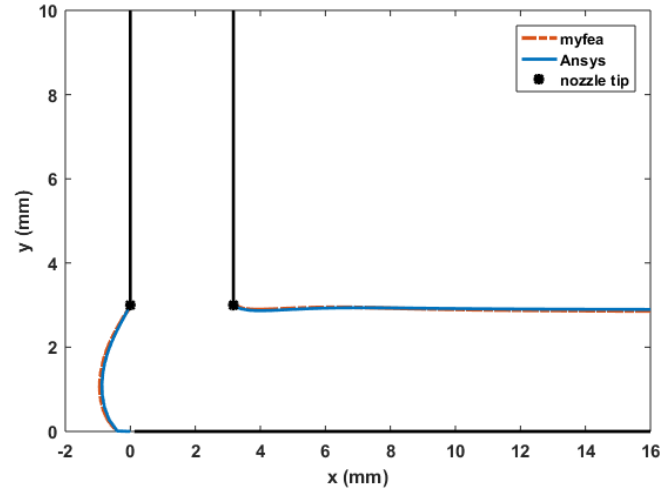
Figure A3. Velocity profiles in the planar deposition region.